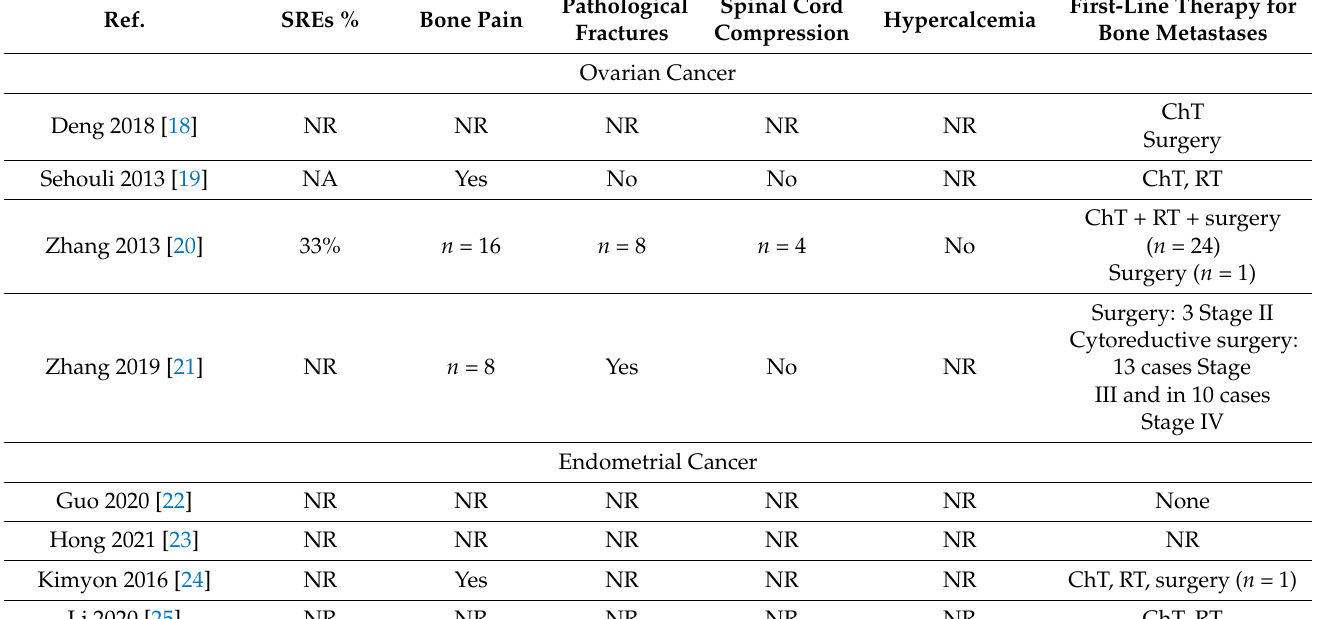
First-Line Therapy for Pathological Spinal Cord Hypercalcemia Bone Metastases Fractures Compression Ovarian Cancer